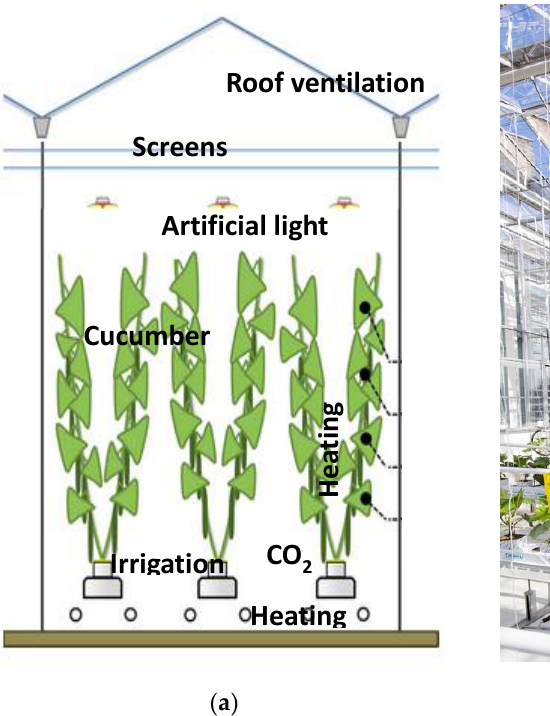
Figure 1. Greenhouse experimental compartments, 96 m 2 ground floor (76.8 m 2 crop-growing area) equipped with different actuators. ( a ) Scheme of compartment with crop and actuators: roof ventilation, two screens, artificial light, irrigation system, CO 2 supply, two heating systems. ( b ) Picture of one compartment with the young crop after the transplant.